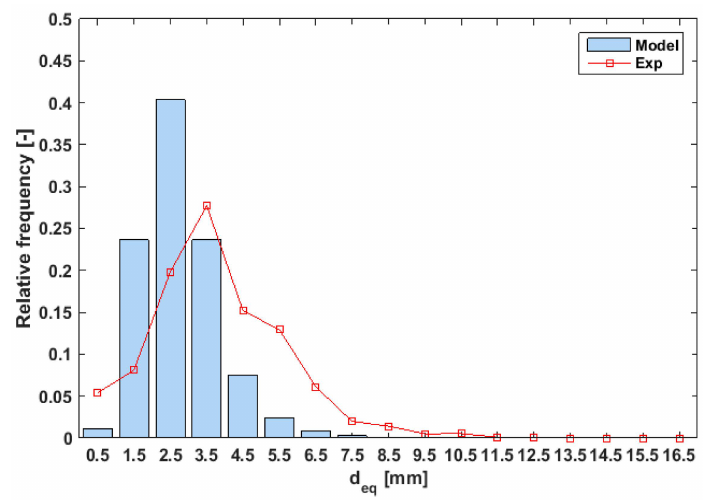
Figure 8. Comparison between PBM and experimental data: uniform BSD at the inlet: U G = 0.0074 m/s.